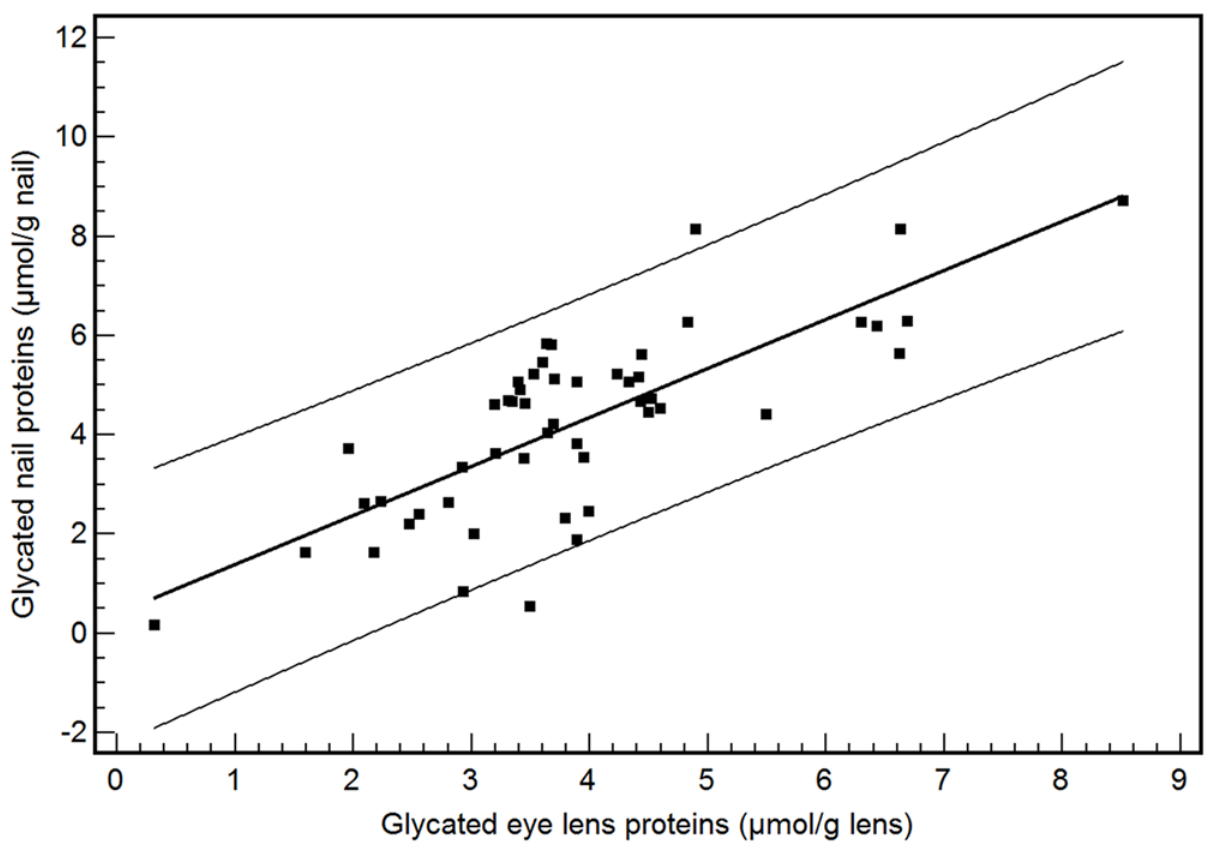
Fig 3. Correlation between glycated nail proteins and glycated eye lens proteins in the combined group of diabetes patients and nondiabetics (n = 51). The equation of linear regression is y (glycated nail proteins) = 0.39 + 0.99 x (glycated eye lens proteins) (r2 = 0.58; P <